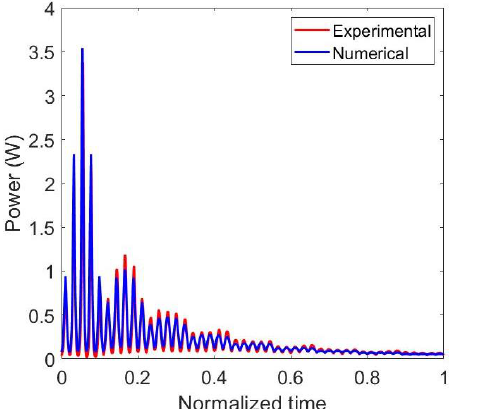
Figure 7. Comparison of experimental and numerical results for the nozzle calibration with the extruder without extrusion of